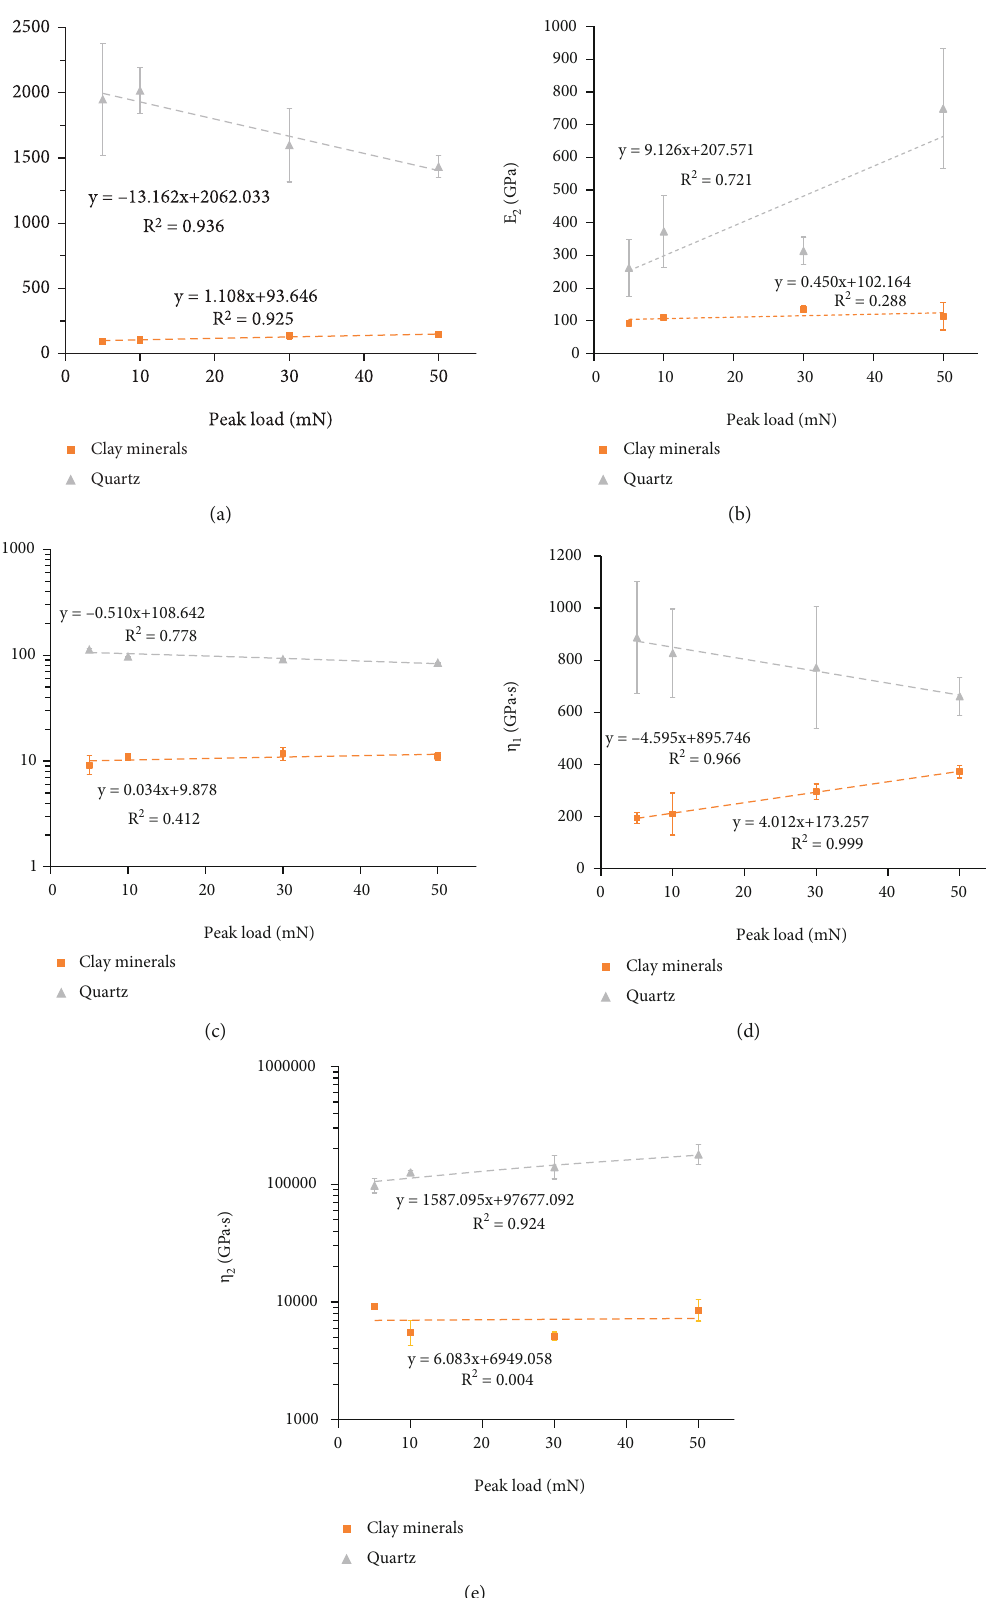
Figure 10: Linear regressions for employing the two-dashpot Kelvin model for quartz and clay minerals at various peak loads. Fitting parameters: (a) E , (b) E , (c) E , (d) η , and (e) η . Error bars are one standard 1 2 3 1 2